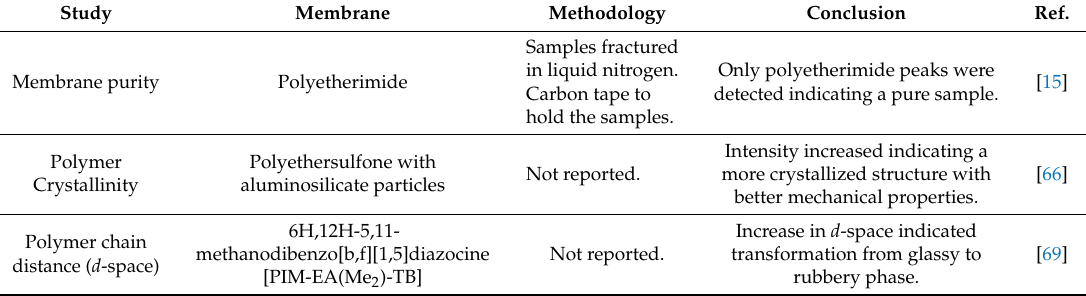
Figure 16. Differentiation of XRD peaks for determining the glassy and amorphous Figure 16. Di ff erentiation of XRD peaks for determining the glassy and amorphous structures [62]. structures [62]. Table 4. XRD studies for characterization of polymeric